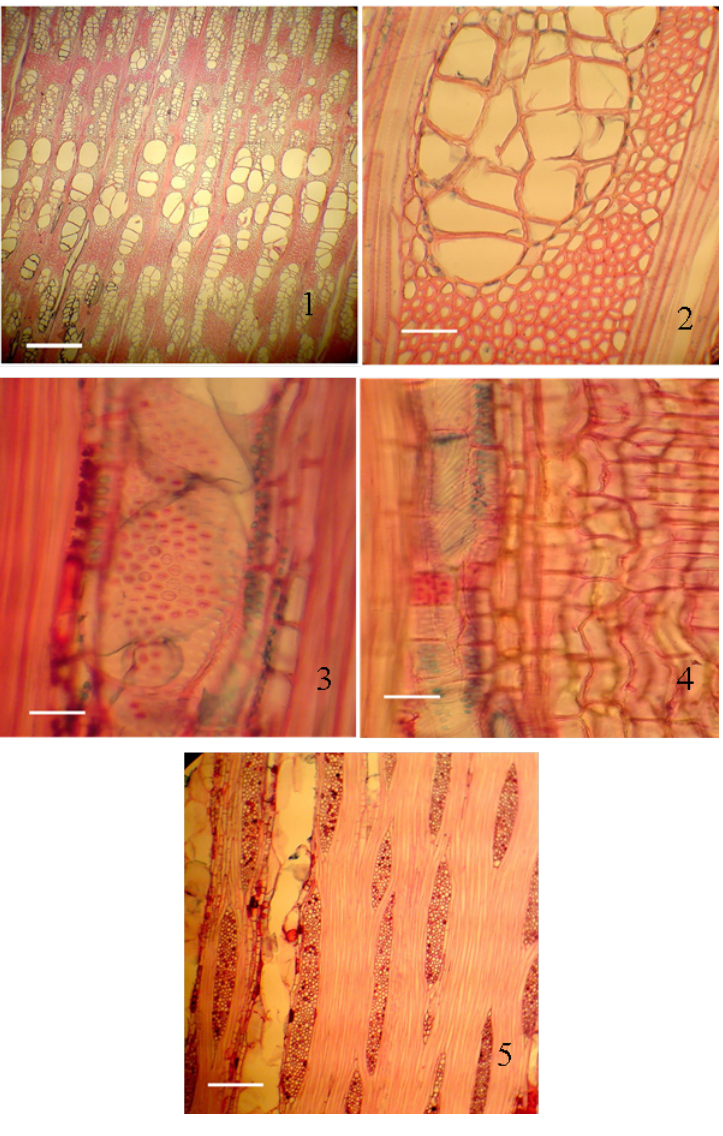
Fig. 1-5. Microscopic sections of Morus alba ; 1-Transverse section; 2-Wall thickness of fibers; 3-Alternative vessel pits; 4-Heli- cal thickening; 5-Tangential section; Scale bars = 100